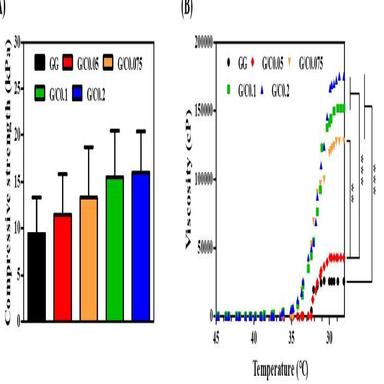
(A) Compressive strength and (B) rheological characteristics (values are mean ± SD, n = 3, P b 0.05 (\), P b 0.01 (\\), P b 0.001 (\\\)).